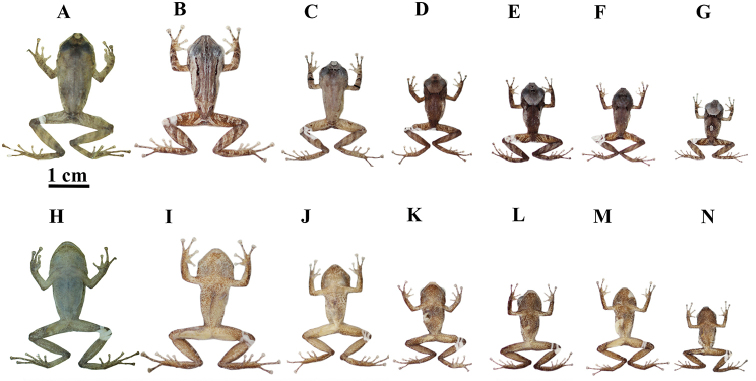
Preserved individuals of Pristimantismallii sp. n. showing dorsal and ventral variation in males A–G dorsal view H–N ventral view. A, HZSFQ 1306, SVL = 21.3 mm B, IQCAZ 52480, SVL = 21.1 mm C, JQCAZ 52481, SVL 15.6 = mm D, KQCAZ 52471, SVL = 12.9 mm E, LQCAZ 52474, SVL = 11.6 mm F, MQCAZ 52478, SVL = 12.2 mm G, NQCAZ 52512, SVL = 10.3 mm.